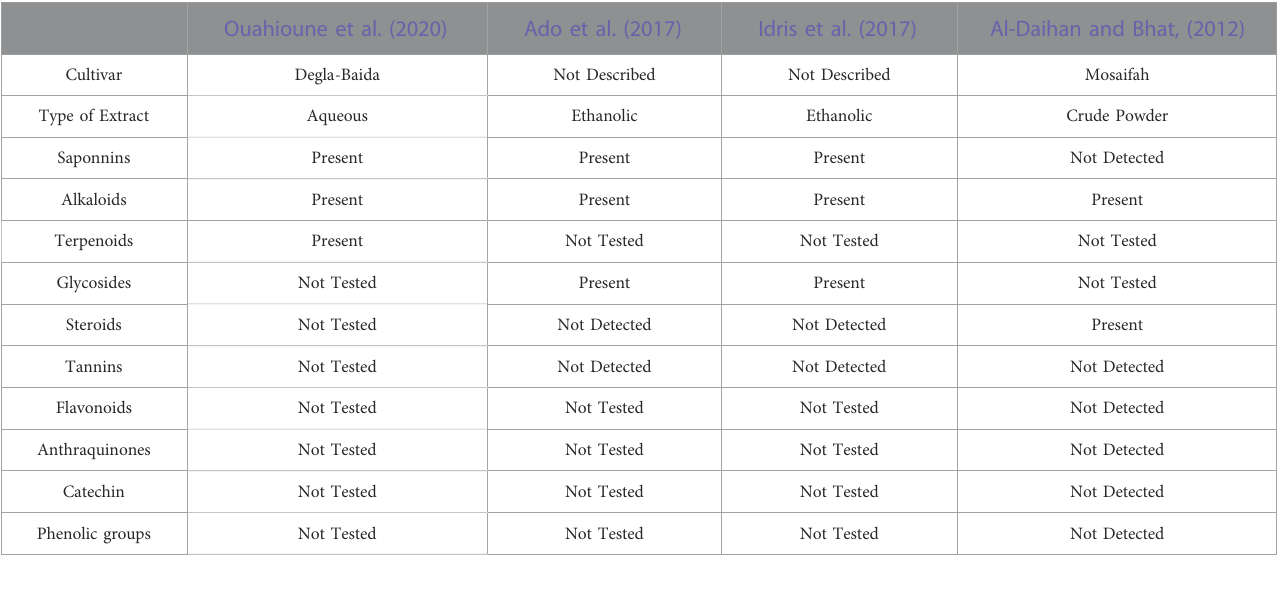
TABLE 1 Phytochemical screening results of included studies.